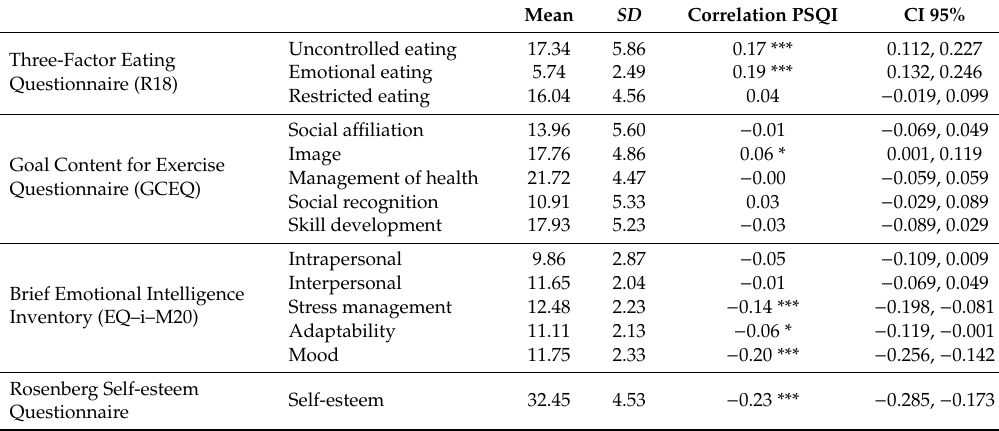
Table 1. Descriptive statistics of factors of eating, physical exercise, emotional intelligence,